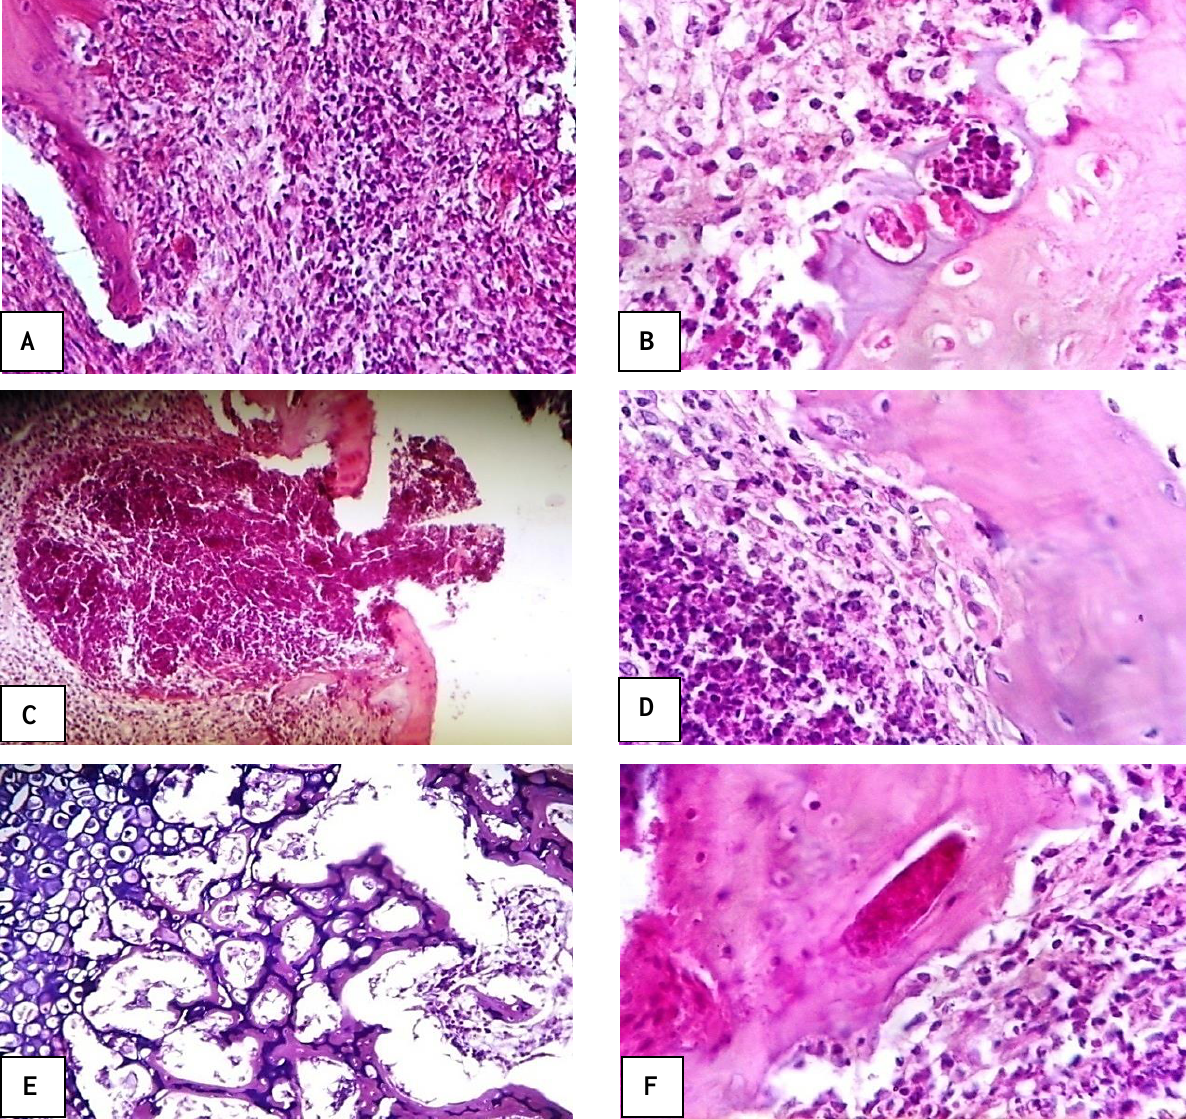
Fig, 2: Histological sections in the ankle joint of the non-immunized animals (30 day post inoculaiton) showed, A: neutrophils infiltration in the synovial membrane and articular cartilage. B: necrosis and destruction of the articular cartilage which invaded by neutrophils. C: pannus reaction. D: inflammatory cells neutrophils and macrophages in the medullary cavity of subchondral bone. E: incomplete endochondral ossification and and fragment of dead bone surrounded by surrounded